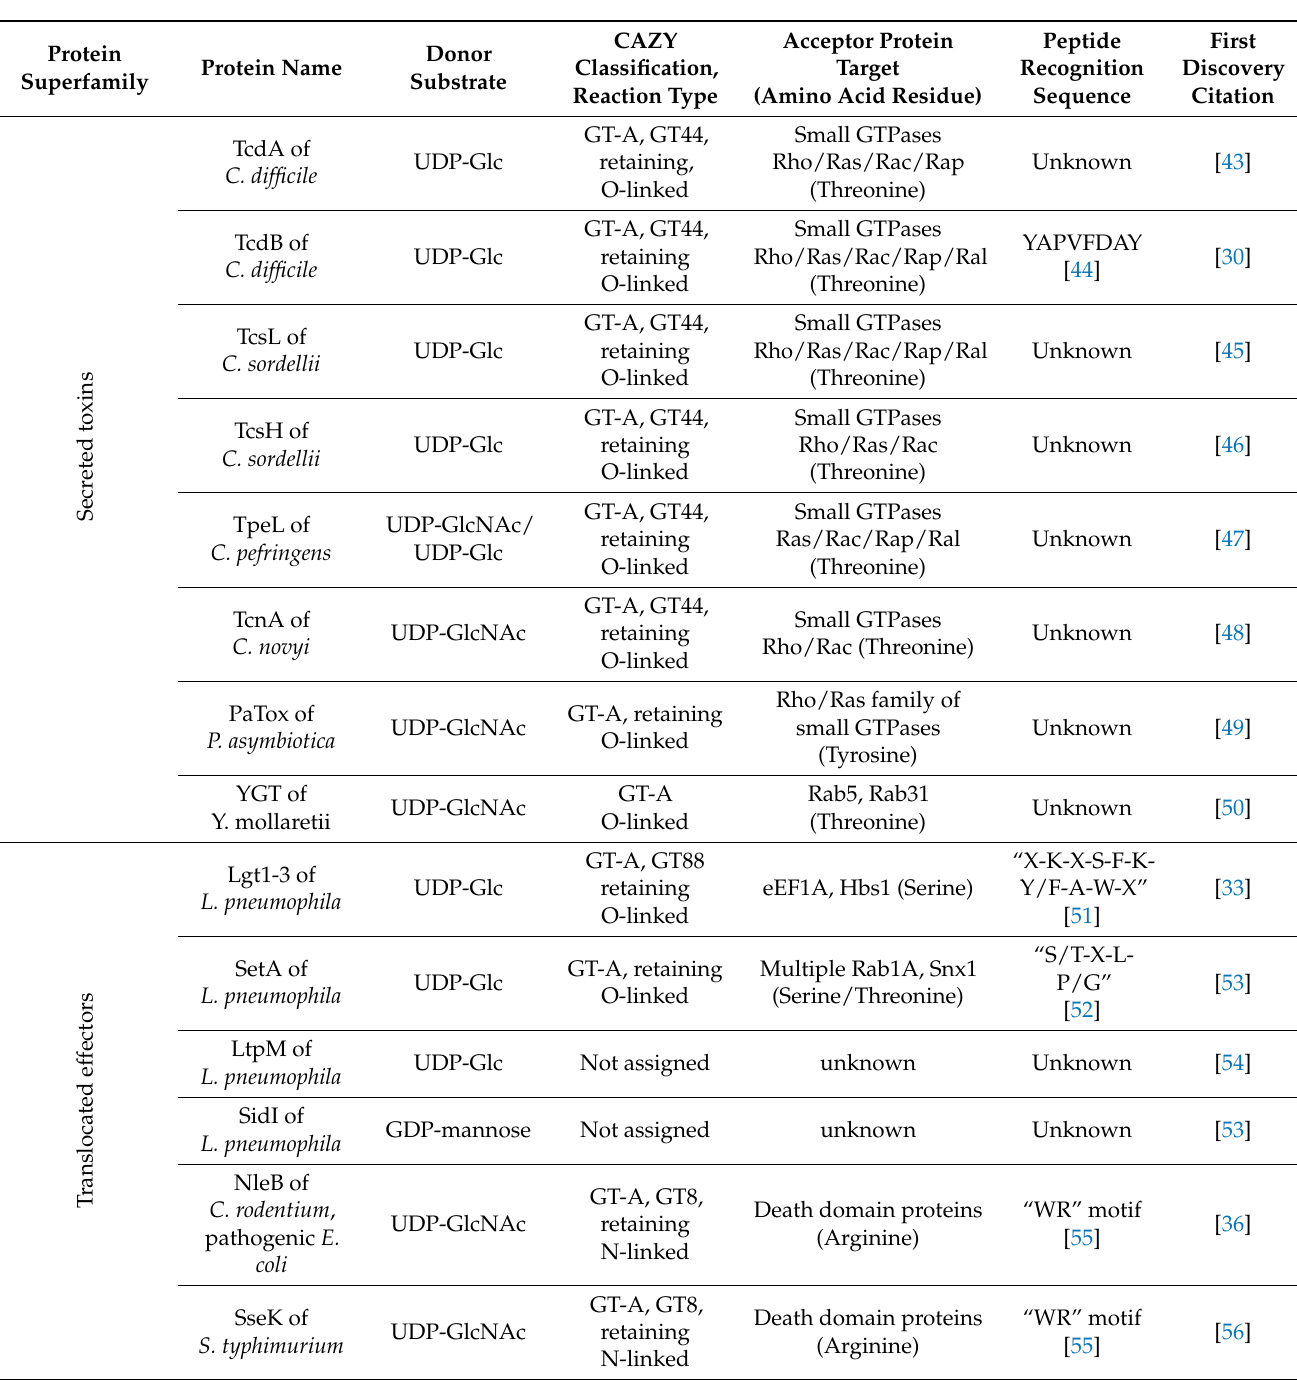
Table 1. Glycosyltransferase toxins and